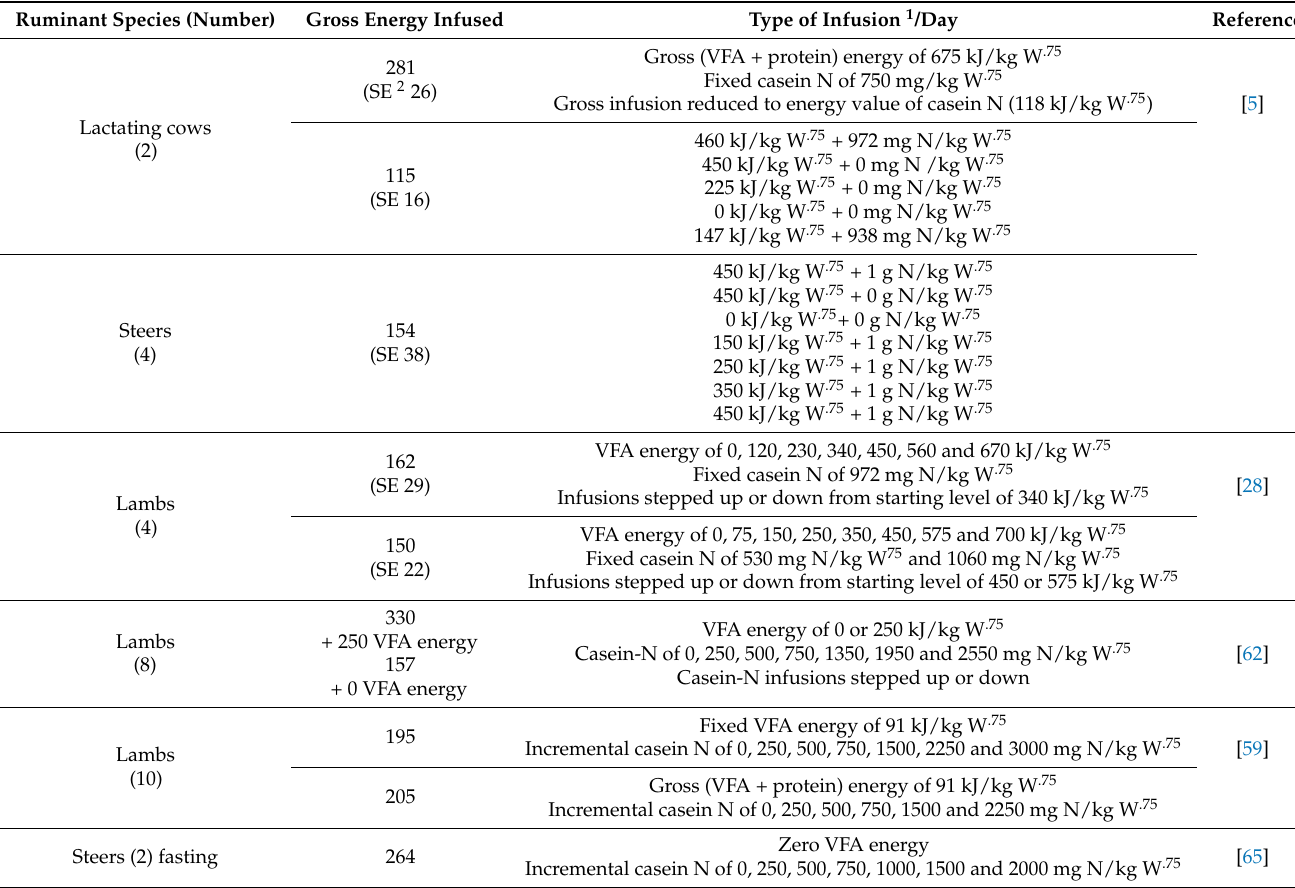
Table 5. Level of gross energy infusion (kJ/kg W .75 ) at which zero N balance was